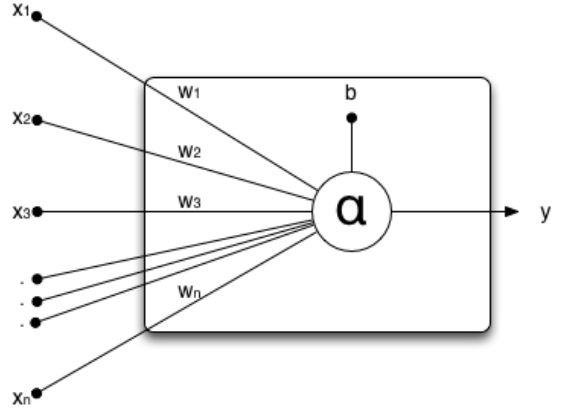
Figure 1. Graphical representation depicting a basic unit of a neuron. Where x = numerical inputs, w = weight, b = bias, α = activation function, and y =